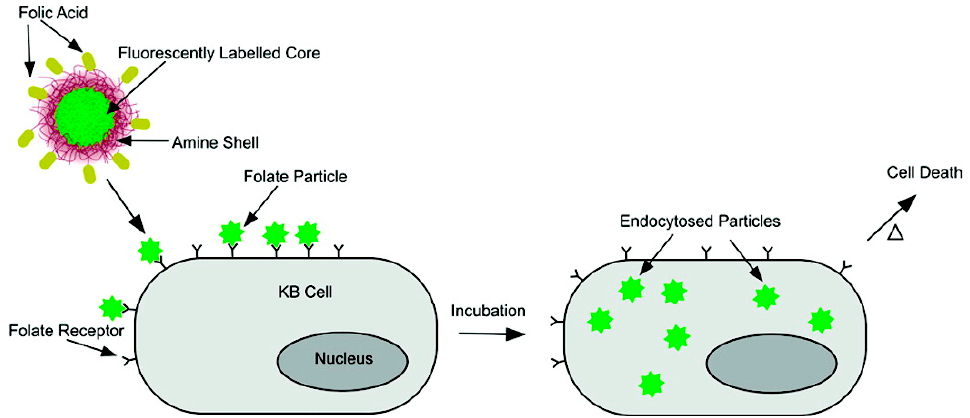
Figure 11. Schematic of targeted pNIPAm hydrogels for cancer cells. The hydrogels are engineered by folic acid to bind with folate receptors on cancer cells [49]. Reproduced from [49] with permission. Copyright (2004) American Chemical Society.